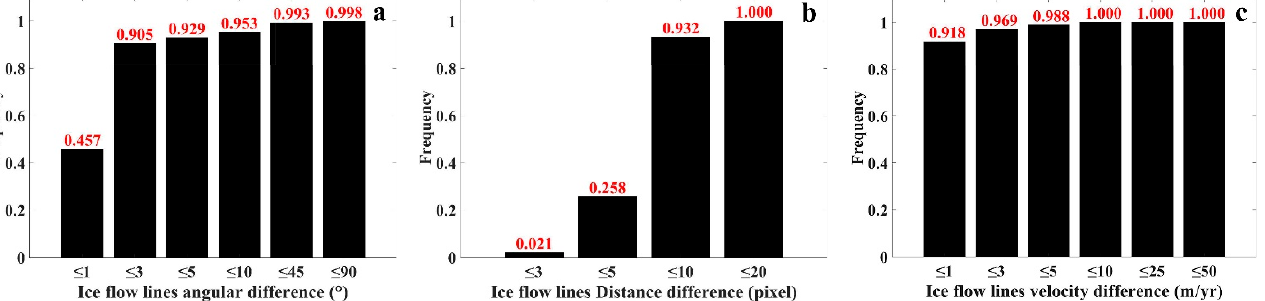
Figure 6. Cumulative frequency distribution histogram of ice flow lines angular difference, distance difference and velocity difference. ( a ) Cumulative frequency distribution histogram of ice flow lines angular difference. ( b ) Cumulative frequency distribution histogram of ice flow lines distance difference. ( c ) Cumulative frequency distribution histogram of ice flow lines velocity difference.